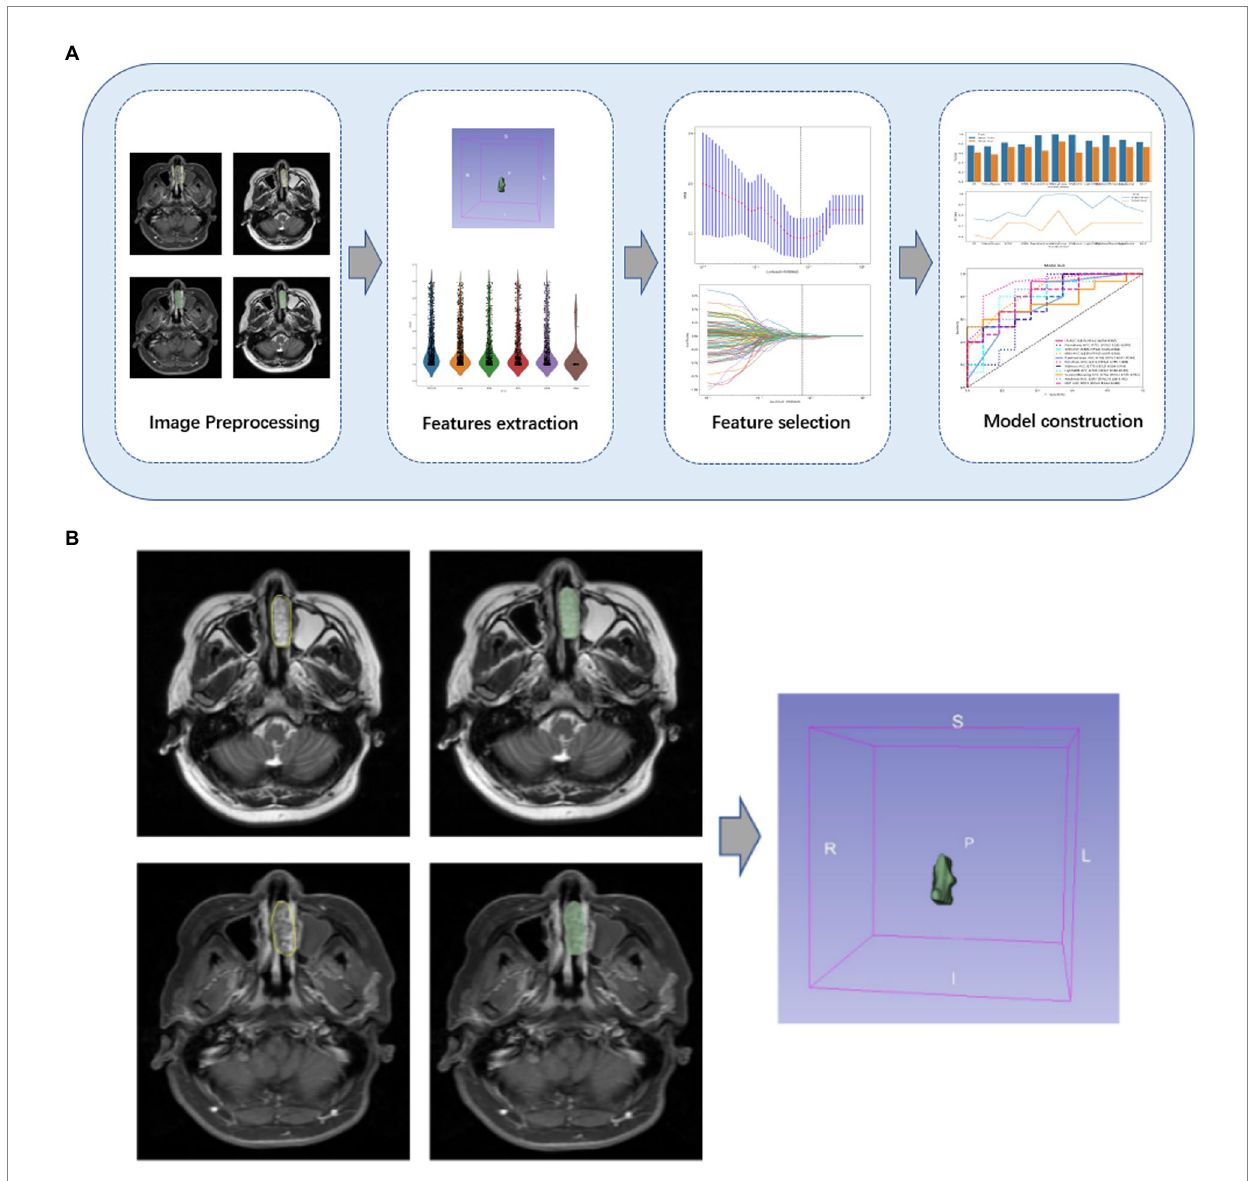
FIGURE 2 (A) Flowchart of the study. An overview of the study workflow including image preprocessing, feature extraction, feature selection, and model construction. (B) Some cases of lesions drawn by radiologists. The tumor contour on the CE-T1WI image was determined, and the CE-T1WI image was referred to when sketching the T2-WI